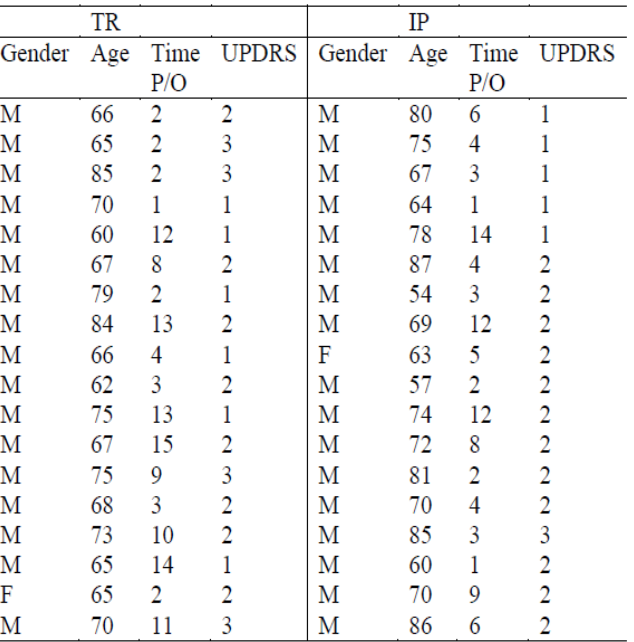
Table 1. Demographics of